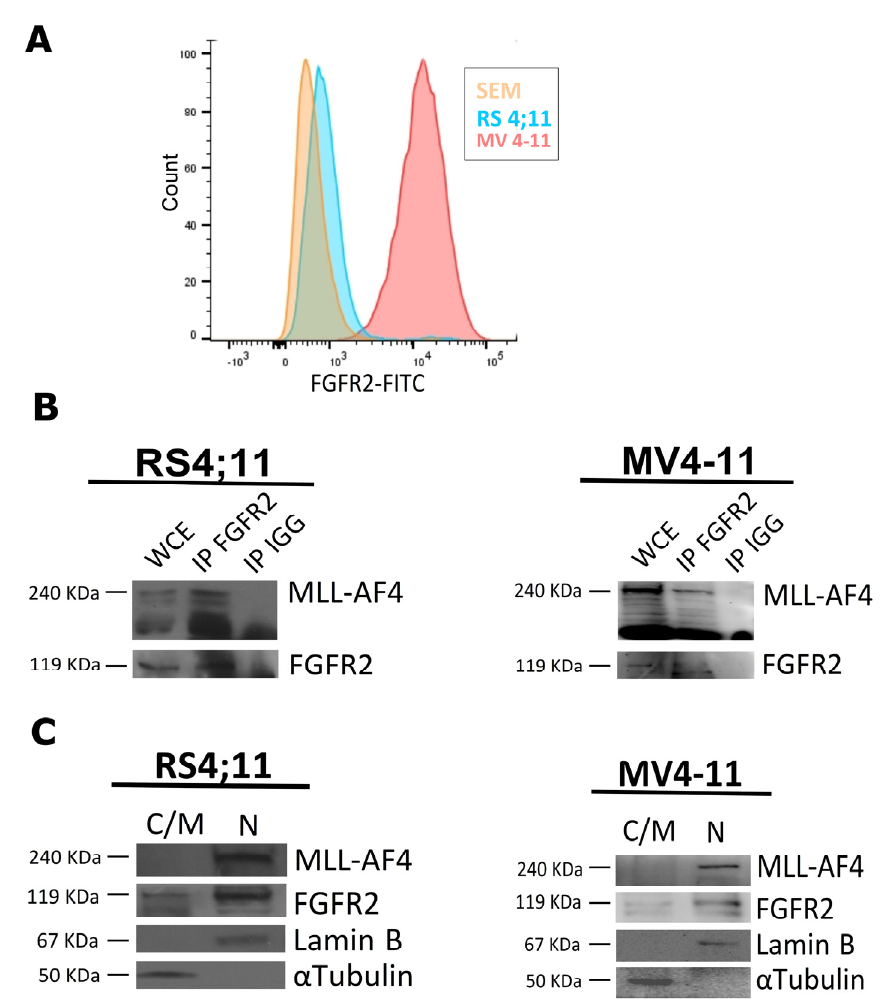
Figure 1. FGFR2 interacts with MLL-AF4 and localizes in the nucleus of t(4;11) leukemia cells. ( A ) Flow cytometry analysis carried out in different leukemia cell lines (SEM, RS4;11, and MV4-11) using anti-FGFR2 antibody and a fluorescein isothiocyanate (FITC)-conjugated secondary antibody. ( B ) Endogenous FGFR2 was immunoprecipitated from whole cellular extract (WCE) of RS4;11 and MV4-11 cells with anti-FGFR2 antibody (IP FGFR2) and with anti-IgG (IP IGG) antibodies, and isolated using A/G plus agarose beads; immunocomplexes were analyzed by western blot, with an anti-MLL antibody. ( C ) Twenty micrograms of cytosolic/membrane (C/M) and 50 µg of nuclear (N) proteins extracted from RS4;11 and MV4-11 cells were analyzed by western blot with anti-FGFR2 and anti-MLL antibodies; –tubulin and lamin B were used as cytosolic and nuclear control proteins, respectively.